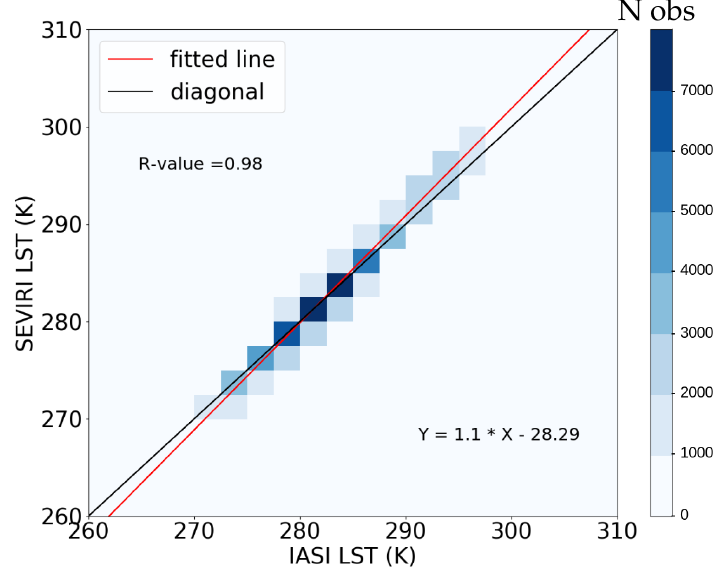
Figure 5. 2D histogram of IASI LSTs vs SEVIRI LSTs for October and November 2018 over the AROME-France domain (day and night data combined). The regression line is in red, the diagonal line is in